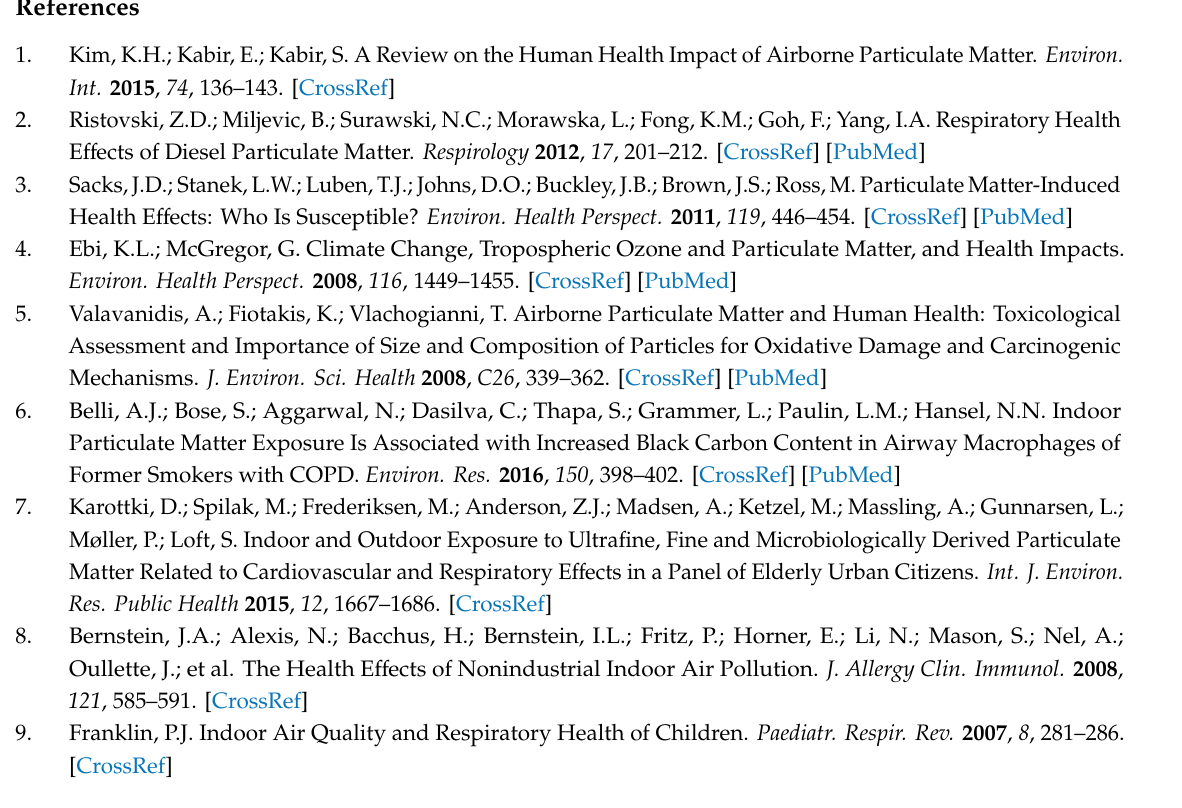
Table S1: Summary of median and distribution of indoor and outdoor PM 2.5 species concentrations. Table S2: Summary of median and distribution of indoor and outdoor PM 10 species concentrations. Figure S1: Harvard samplers collecting PM 10 and PM 2.5 inside a Kuwait home. Figure S2: Harvard samplers collecting PM 10 and PM 2.5 outside a Kuwait home. Table S3: p -values from Shapiro-Wilks test of normality, t-test with identity means, t-test with log-transformed means, and Wilcoxon test, comparing fine element indoor to outdoor concentration in dust events versus no dust events (Corresponds to Figure 2). Table S4: p -values from Shapiro-Wilks test of normality, t-test with identity means, t-test with log-transformed means, and Wilcoxon test, comparing coarse-to-fine mean ratios in indoor versus outdoor. (Corresponds to Figure 3). Figure S3: Box plots illustrate the di ff erence between I / O concentration ratios of PM 2.5 mass, BC and 19 elements during dust and non-dust events after excluding H2. Figure S4: Box plot illustrates coarse-to-fine particle ratios of mass and elements measured indoors and outdoors after excluding H2. Figure S5: Histogram illustrates the median of outdoor fine Fe concentrations that we utilized as a threshold for dust storm events